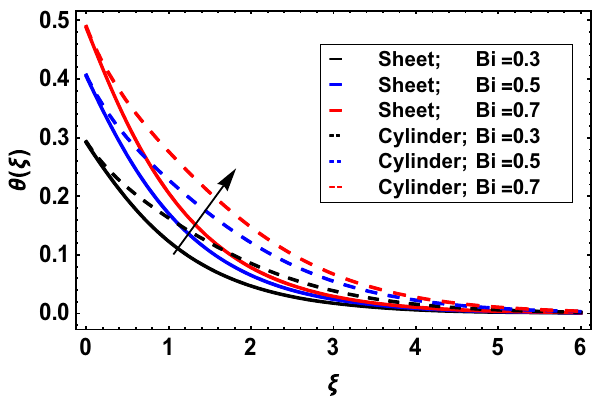
Figure 9: Change in nano fl uid temperature due to